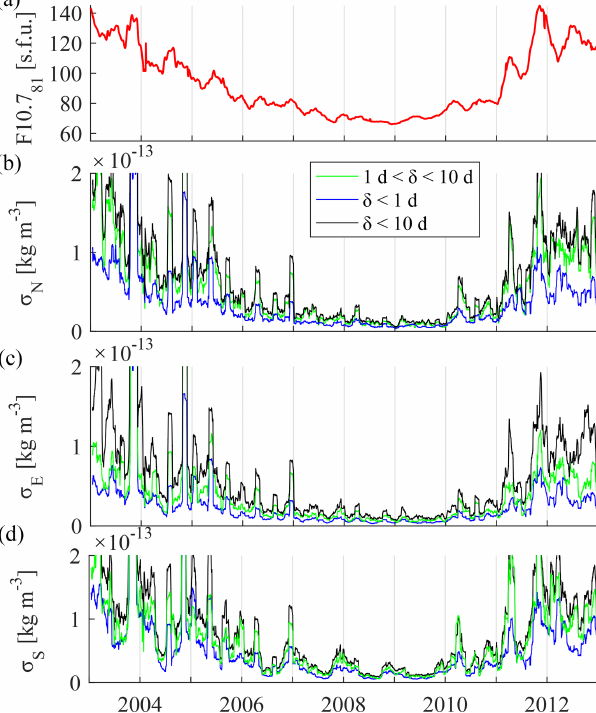
Figure 2. From top to bottom, (a) the 81d averaged F10.7 solar flux index, and the 30d standard deviation sliding window of residual density disturbances at an altitude of 475km in (b) the northern, (c) the equatorial, and (d) the southern regions. Calculations filtered at different frequencies are plotted in green, blue, and